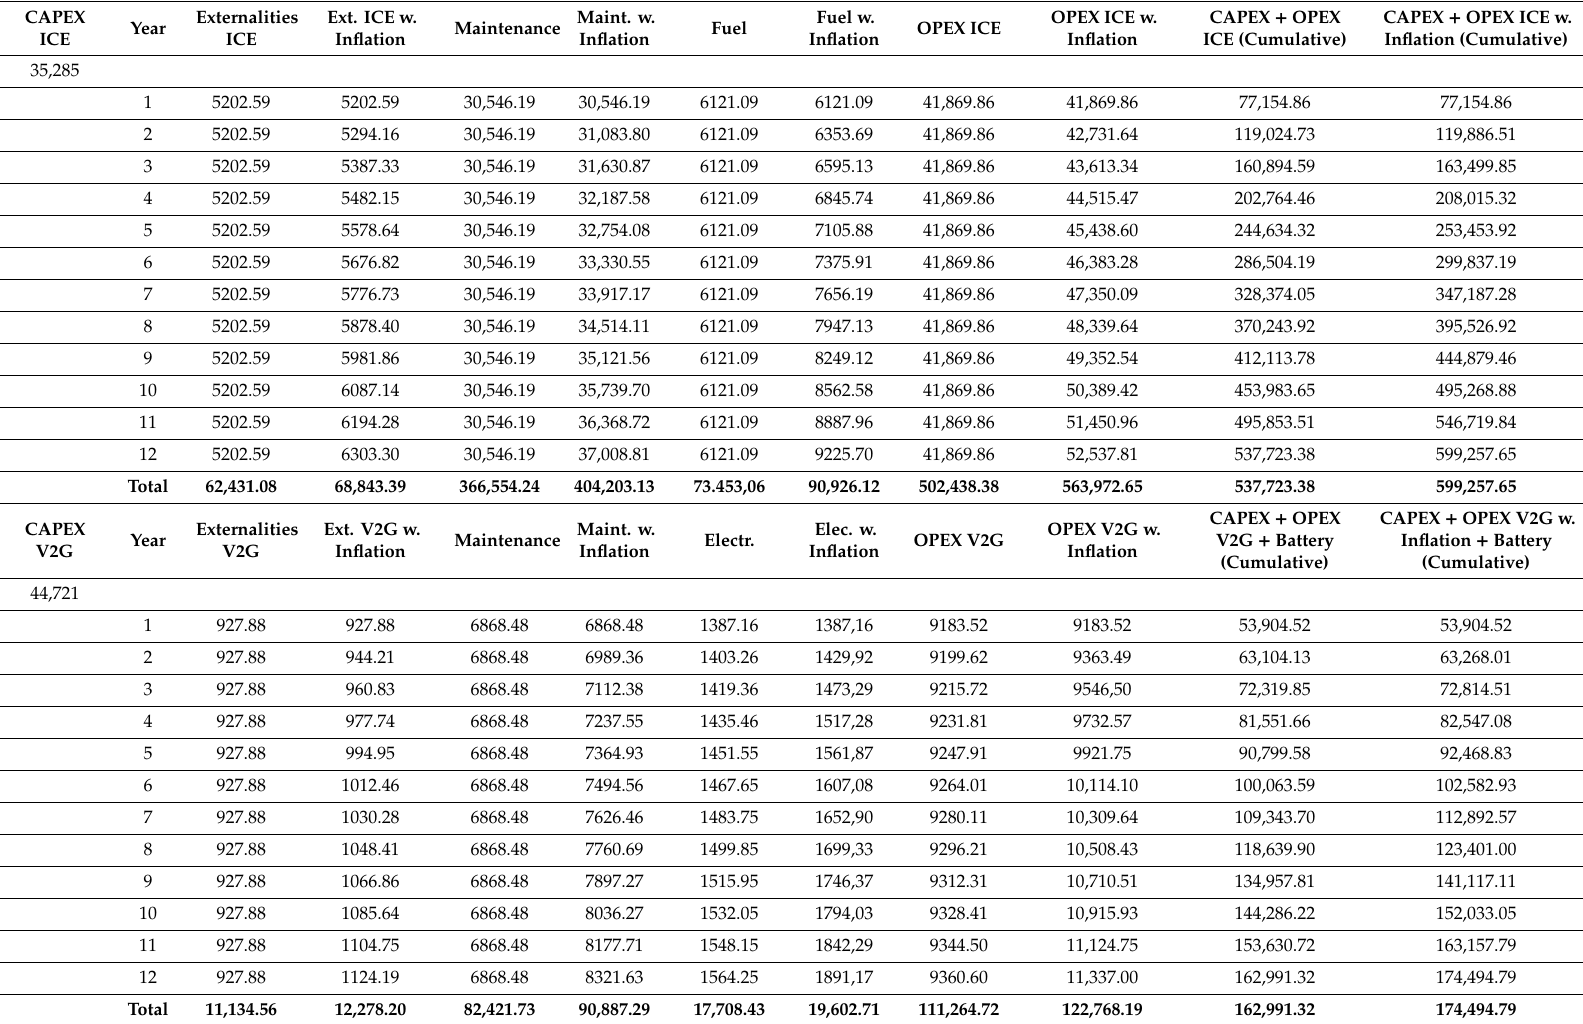
Table A1. Cumulative costs for ICE and V2G solutions, professional drivers (figures are in